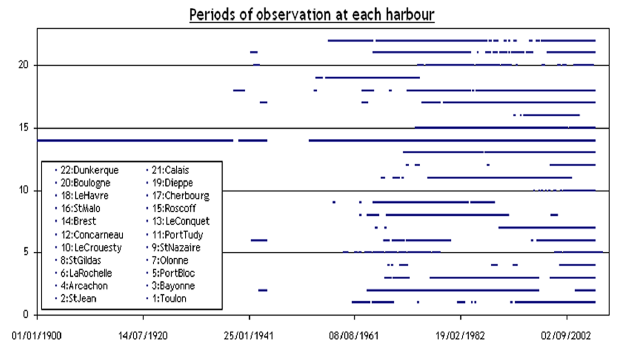
Fig. 3. Detail of the continuous periods of observation by the tide gauges at each harbour for the period 1900–2009. Before the year 1900, only the tide gauge at Brest recorded sea level data (until